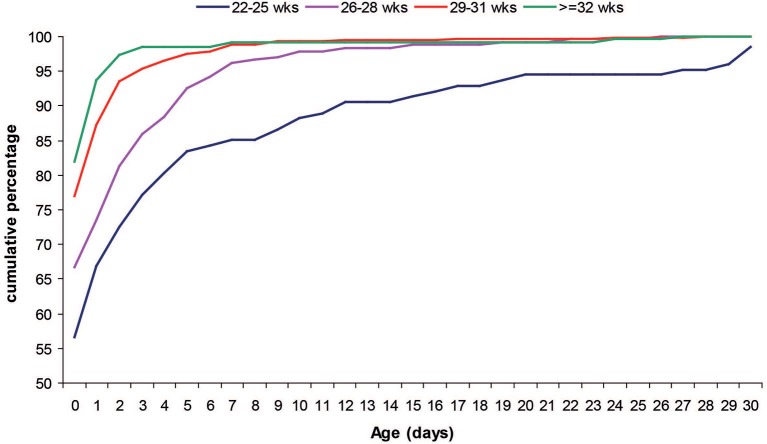
Postnatal age at the beginning of enteral feeding by GA classes.